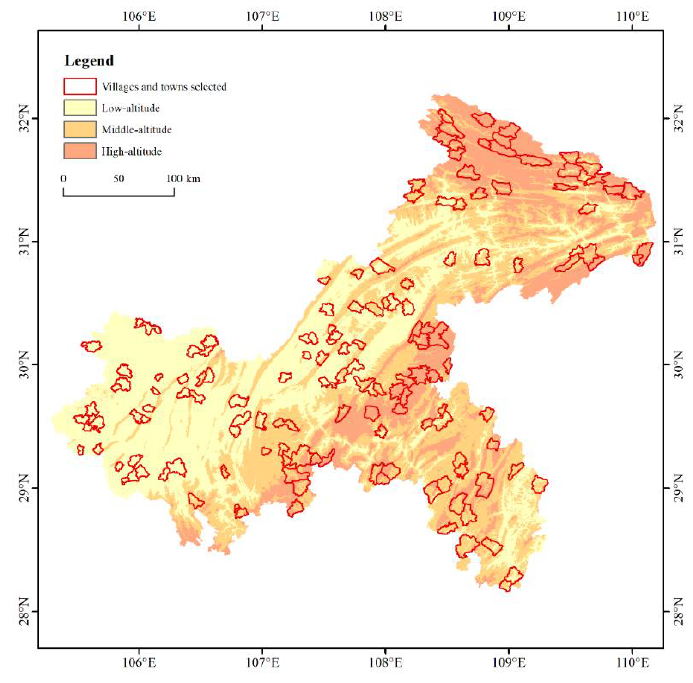
Figure 5. Spatial distribution of the villages and towns selected.